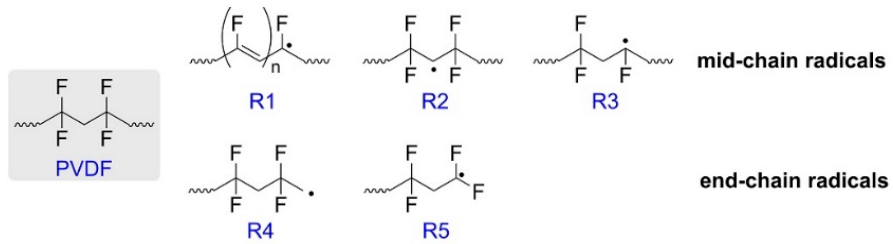
Figure 5. Observed radiation-induced PVDF radicals